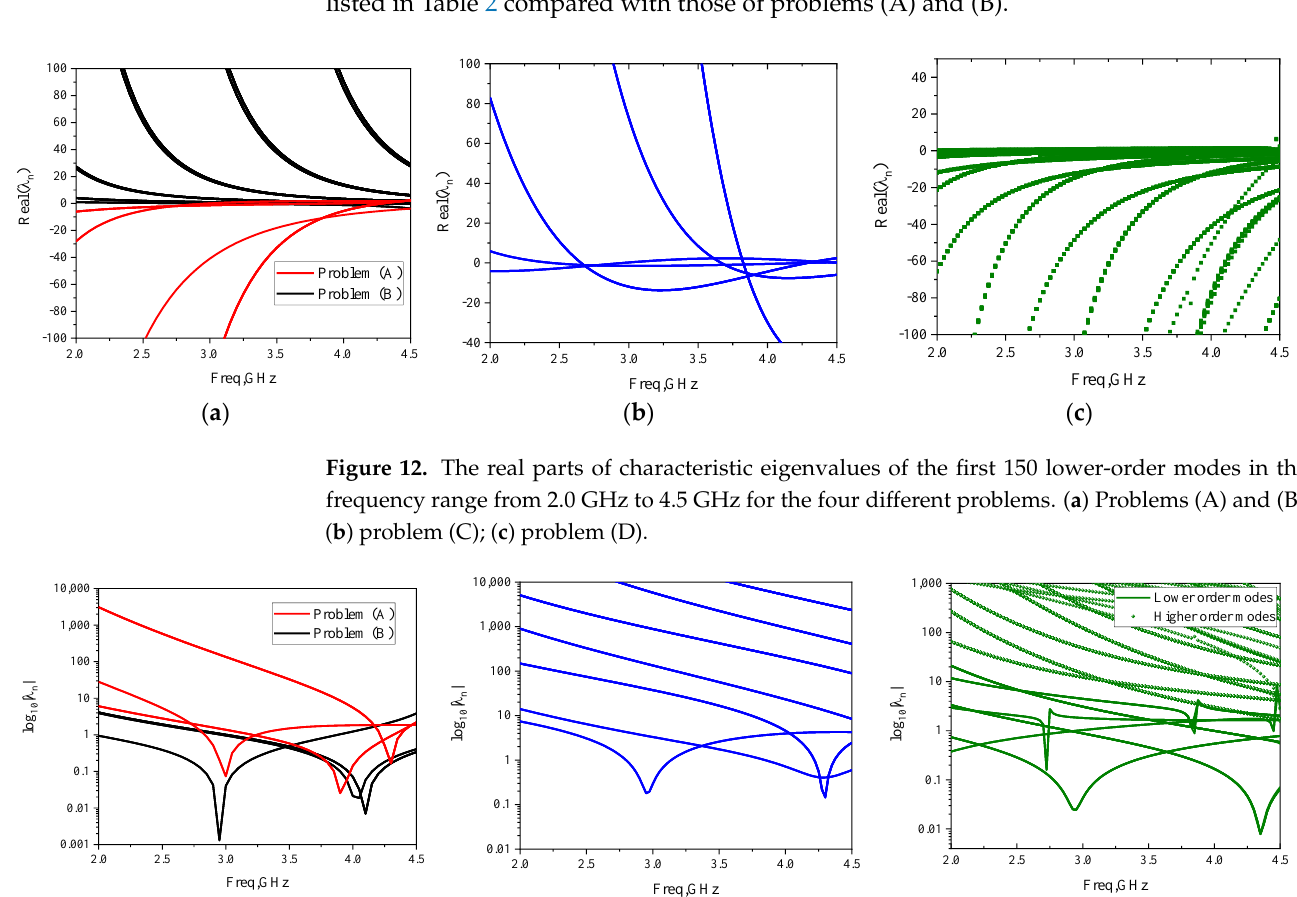
listed in Table 2 compared with those of problems (A) and (B).